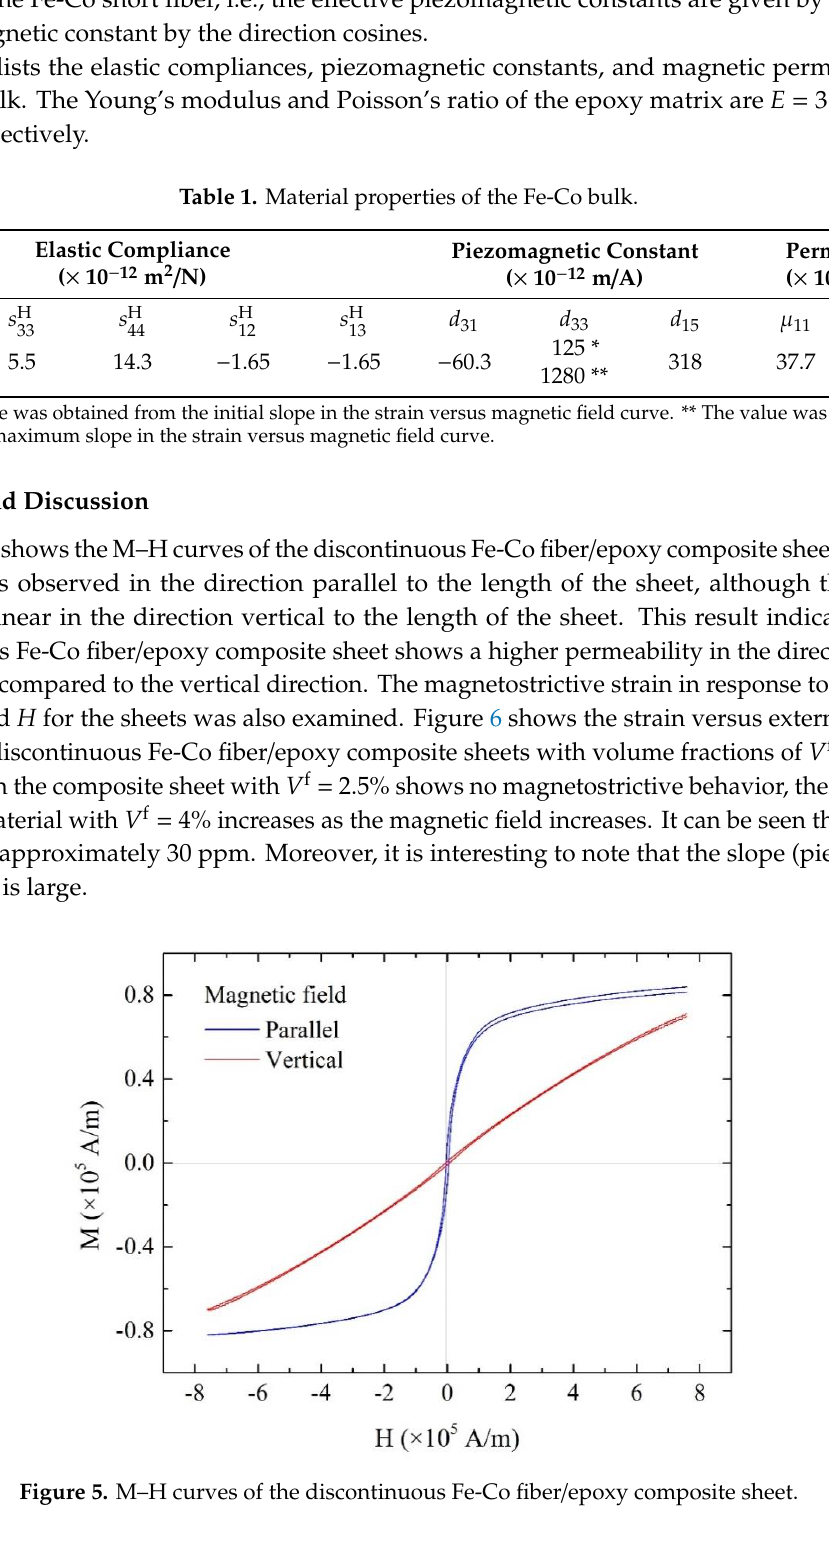
Figure 6. Strain versus external magnetic field of the discontinuous Fe-Co fiber/epoxy composite sheets. In order to predict the effective piezomagnetic constant 𝑑 33rc , the piezomagnetic constant d 33 of the Fe-Co fiber has to be used because it is expected that the piezomagnetic constants d 33 of the Fe-Co fiber and Fe-Co bulk are different. This is due to the difference of the microstructure between the Fe- Co fiber and Fe-Co bulk. Figure 7 shows the microstructure and crystallographic orientations for the cross-sections of the Fe-Co fiber with a diameter of 50 μm. We found a strong texture in the fiber, that is, the superior texture obtained in the fiber direction due to the wire drawing. It is expected that the value of the piezomagnetic constant d 33 of the Fe-Co fiber will be very high.